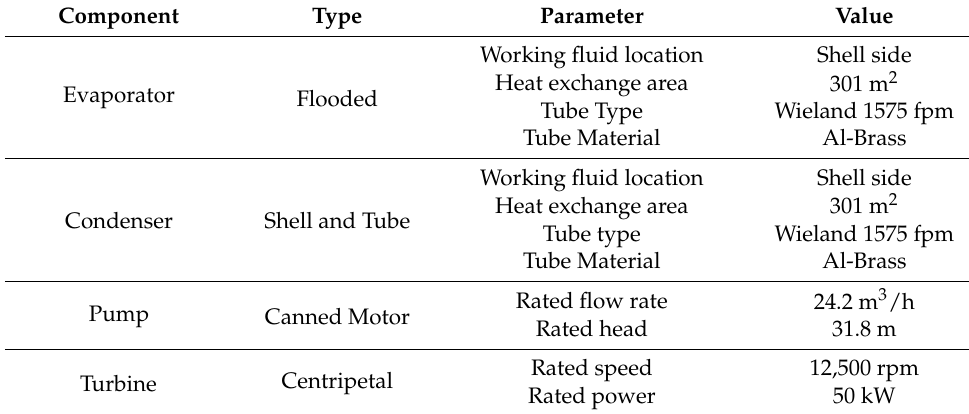
Table 2. Detailed information for the pipe